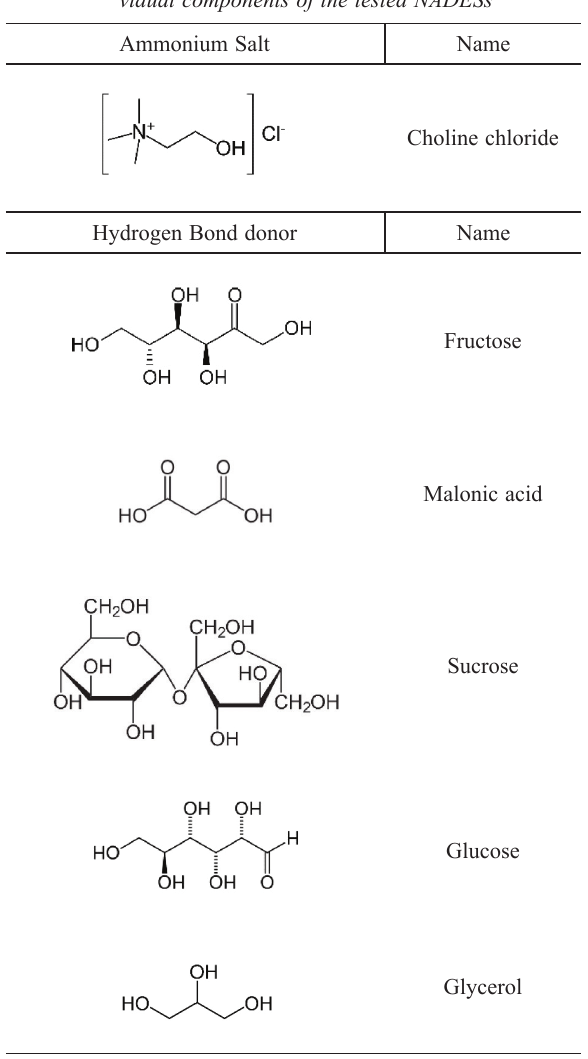
Table 1 – Structures, names, and abbreviations of the indi- vidual components of the tested NADESs